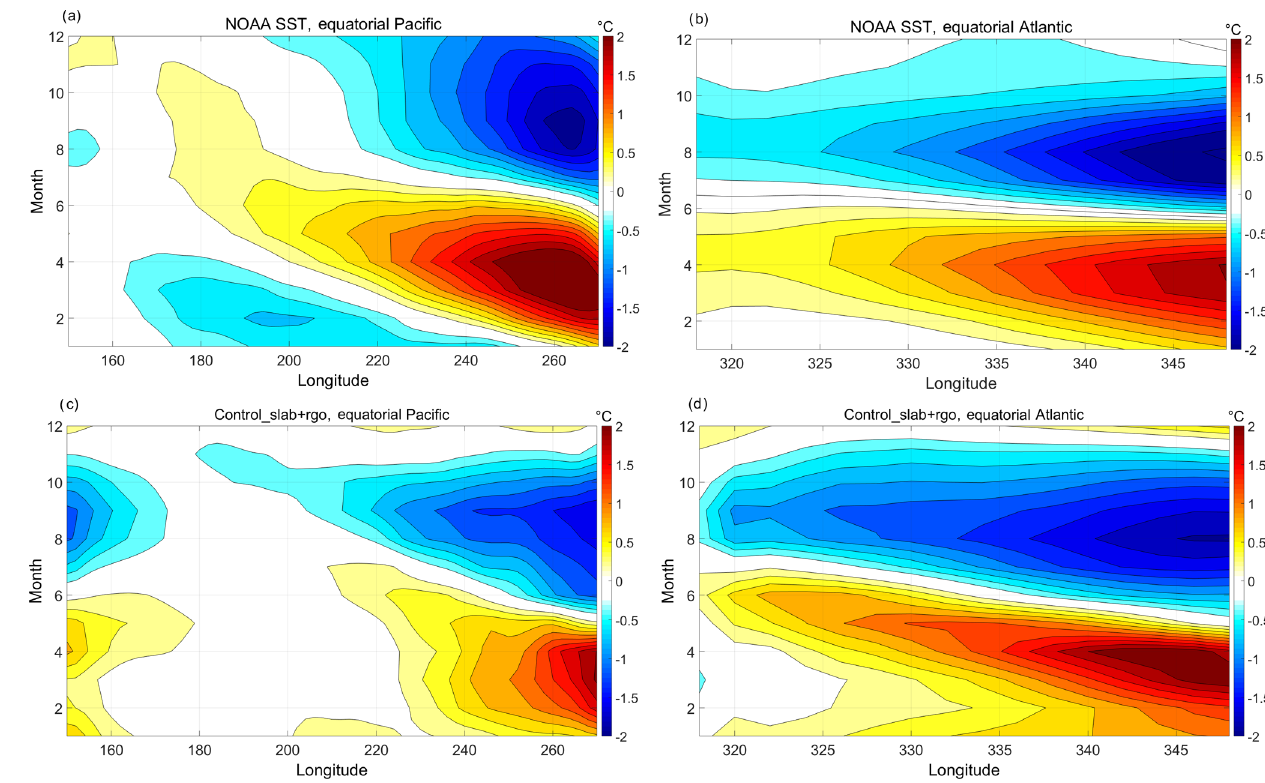
Figure 1. (a, b) De-meaned SST seasonal cycle from NOAA SST data (Smith et al., 2008) in the equatorial Pacific (2 ◦ S–2 ◦ N, 150–270 ◦ E) and Atlantic (2 ◦ S–2 ◦ N, 320–345 ◦ E) respectively. (c, d) De-meaned SST seasonal cycle for Control_slab + rgo in the equatorial Pacific and Atlantic respectively. Contour interval: 0.2 ◦